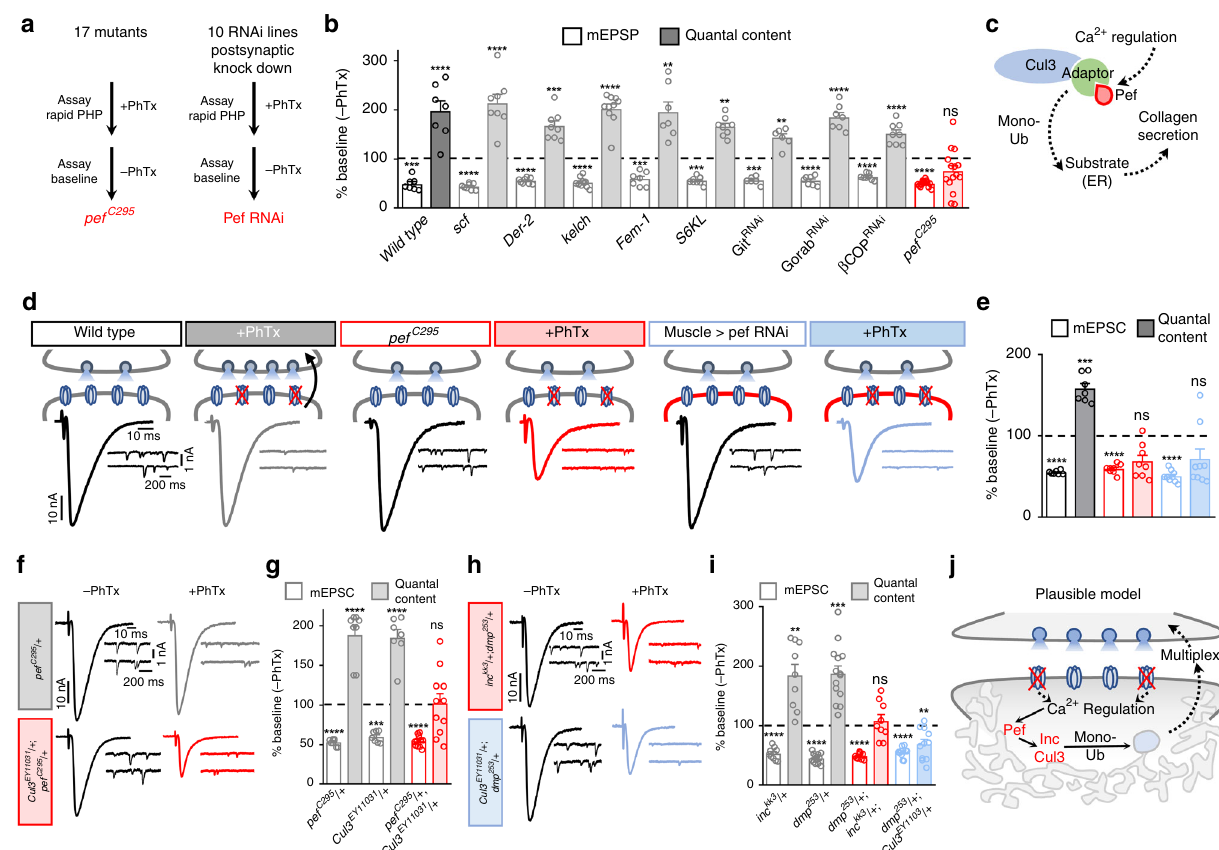
Fig. 6 An Inc- and Cul3-interaction screen identi fi es pe fl in to be required postsynaptically for PHP expression. a Flow diagram and screening strategy of Inc- and Cul3-interacting genes identi fi es a mutation and RNAi line targeting Drosophila pe fl in ( CG17765 ; pef ). b Quanti fi cation of mEPSP and quantal content values in a subset of mutants screened normalized to baseline values ( – PhTx) ( n = 6 – 20; see Supplementary Table 1). c Schematic summarizing the role of mammalian Pef functioning as a co-adaptor for the Cul3-KLHL12 complex, which is regulated by Ca 2 + signaling. This signaling activates Cul3 KLHL12 to mono-ubiquitinate substrates involved in membrane traf fi cking at the ER to modulate Collagen secretion. d Schematic and representative traces of wild type, pe fl in mutants ( pef C295 ), and Pef RNAi driven in the postsynaptic muscle (muscle > Pef RNAi: G14-Gal4/UAS-Pef RNAi ) before and following PhTx application. Note that while mEPSC amplitude is reduced in all three genotypes after PhTx application, PHP fails to be expressed in pef C295 and muscle > Pef RNAi. e Quanti fi cation of mEPSC and quantal content values in the indicated genotypes normalized to baseline values ( – PhTx: wild type, n = 8; pef C295 , n = 7; muscle > Pef RNAi, n = 10; + PhTx: wild type, n = 7; pef C295 , n = 8; muscle > Pef RNAi, n = 9). Representative traces ( f and h ) and quanti fi cation ( g and i